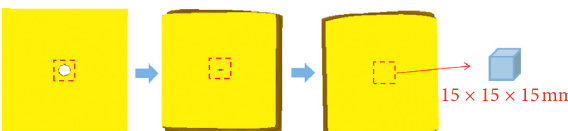
Figure 2: Sampling diagram of the metallographic specimen (unit: mm).